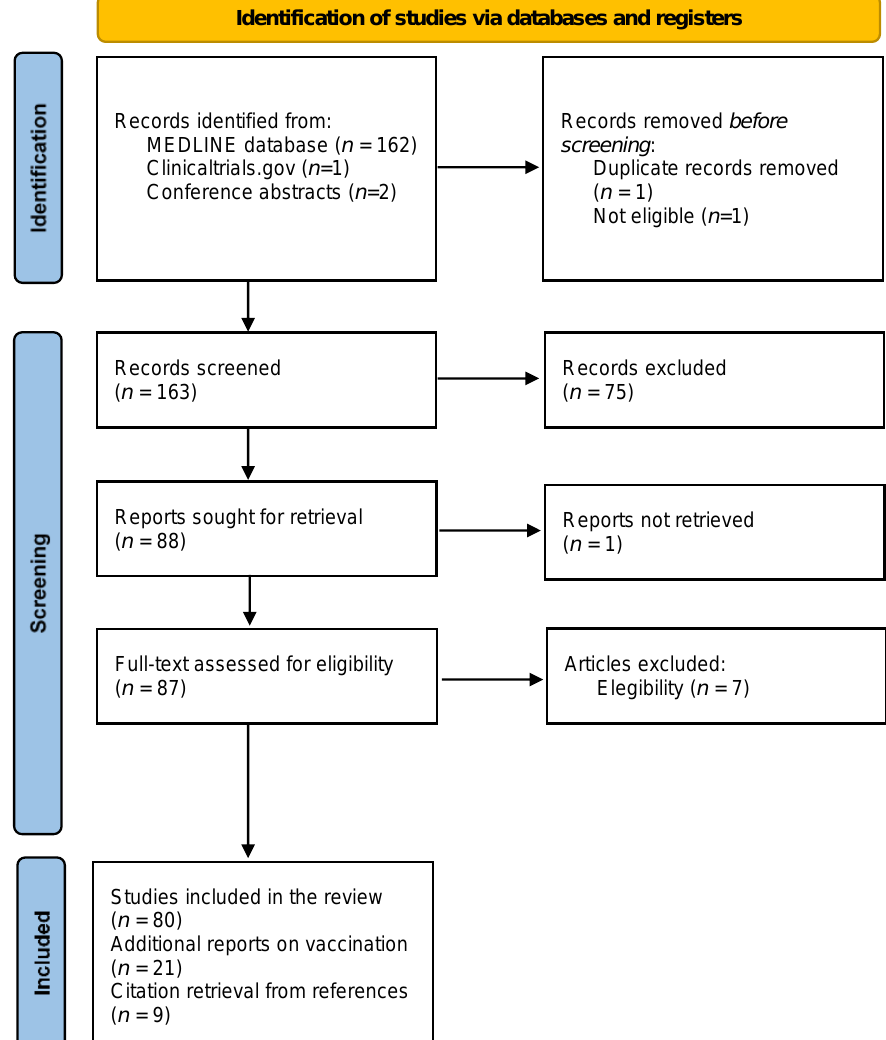
Figure 1. Flow-chart representing study selection according to PRISMA criteria. Glatiramer acetate (GA) competes with myelin antigens for the interaction with histocompatibility major complex molecules in antigen-presenting cells, shifting from a pro- inflammatory to an anti-inflammatory response. As IFN, it does not promote lymphopenia. Furthermore, GA blocks IFN gamma mediated activation of macrophages, which is thought to play an essential role in acute respiratory distress syndromes [10,26]. We found a total of 269 patients under GA with confirmed ( n = 196) or suspected ( n = 73) infection by SARS-CoV-2 [8,10,11,15,16,18–25,29–31]. Four (1.5%) of these patients died due to